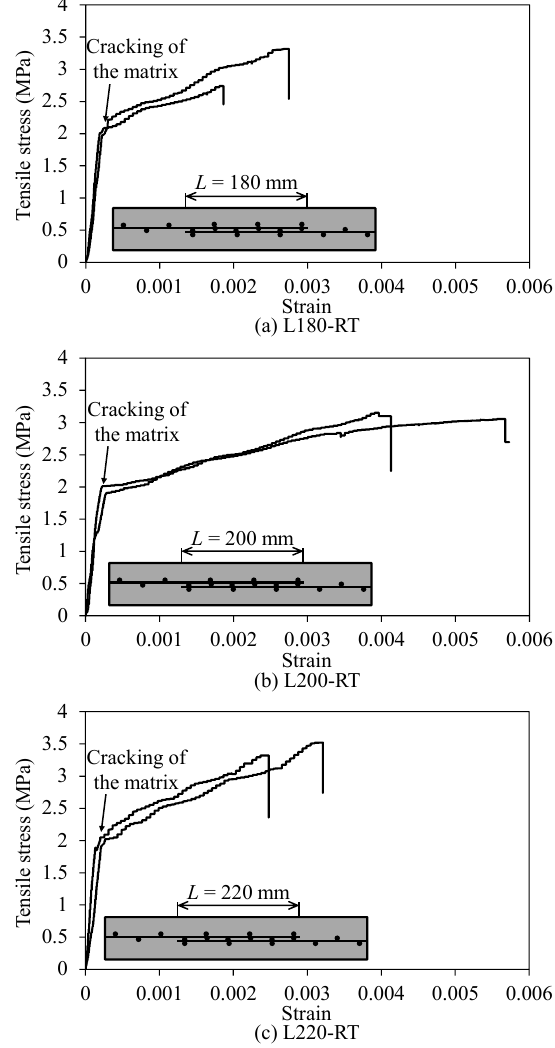
Figure 12. Stress–strain relationship of test specimens in the first series.